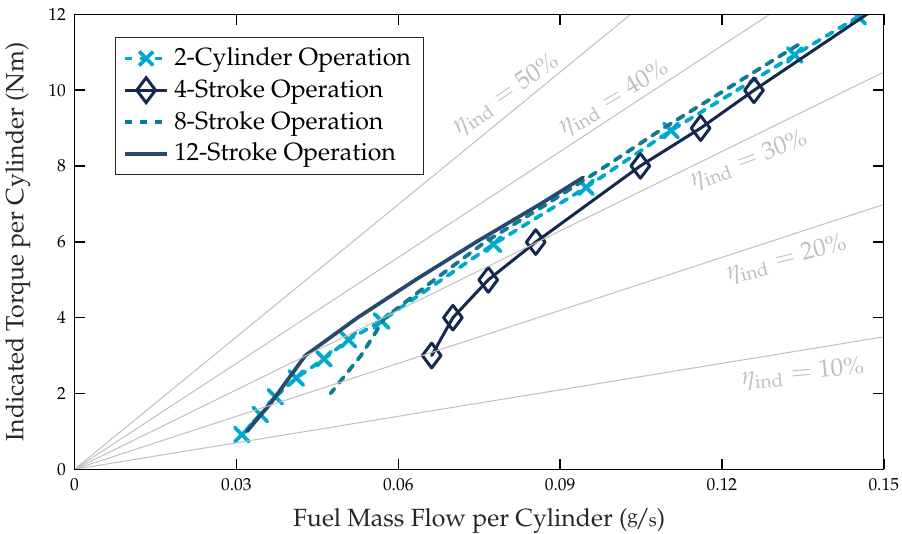
Figure 8. Measured load variations in 4-, 8-, 12-stroke four-cylinder operations and a four-stroke two-cylinder operation plotted as Willans